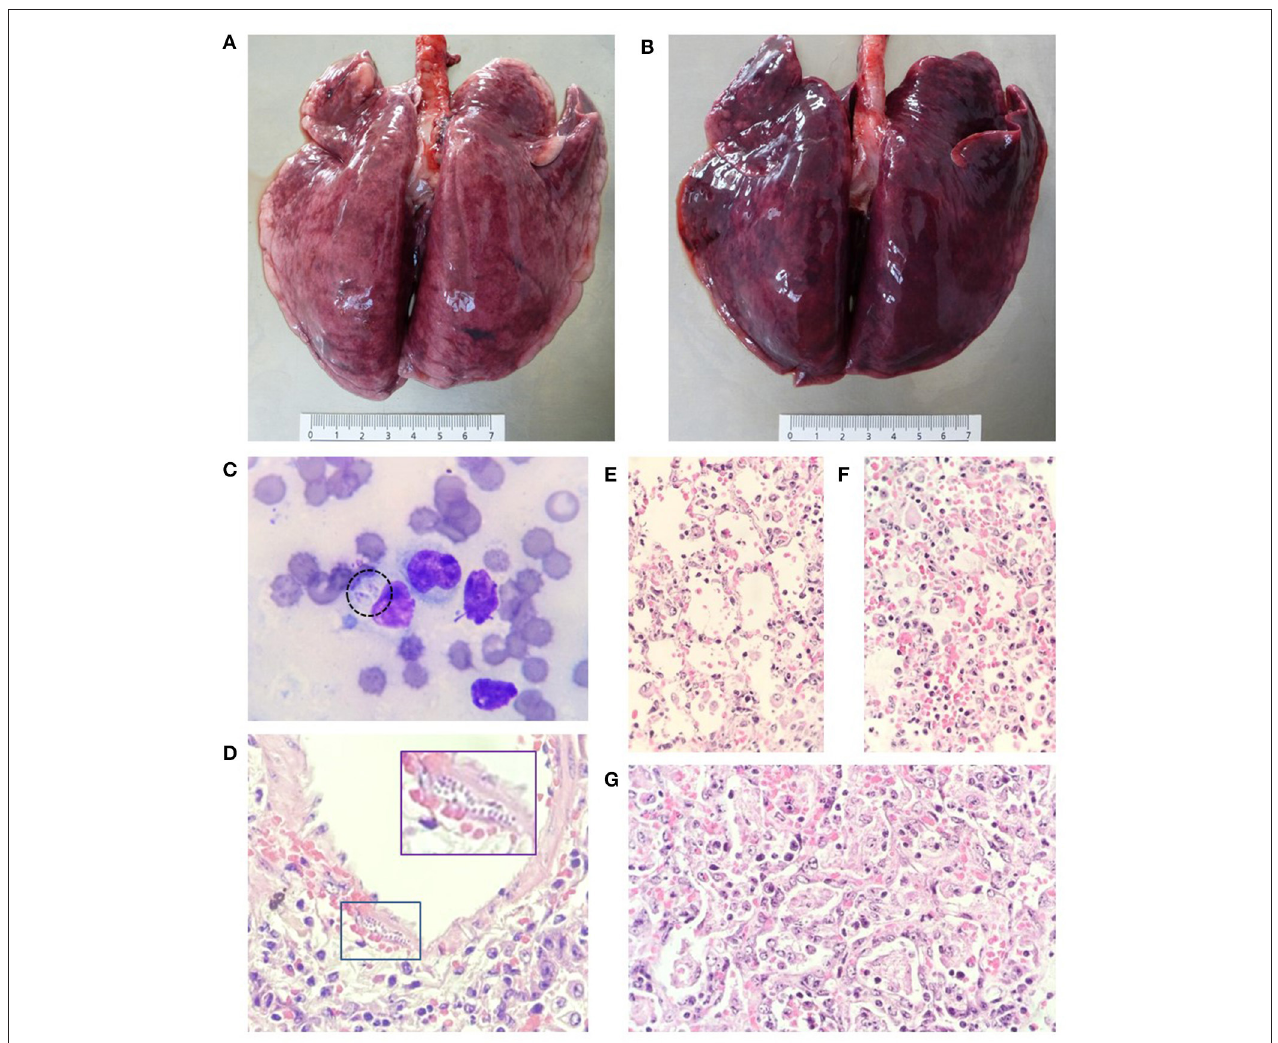
FIGURE 1 | Acute lesions in the respiratory system of both macropods. (A,B) Lung lobes with different degrees of interstitial pneumonia and generalized congestion. (C) Cytology of lung parenchyma with the presence of alveolar macrophages and two replicating tachyzoites can be seen in the cytoplasm of one of them (dotted circle). (D–F) Sections of the lung with different degrees of exudative interstitial pneumonia and the presence of replicating tachyzoites under the muscular layer of a pulmonary artery (box). (E,F) Exudative interstitial pneumonia is seen in some areas. (G) Other areas with hyaline membrane formation, edema, cellular